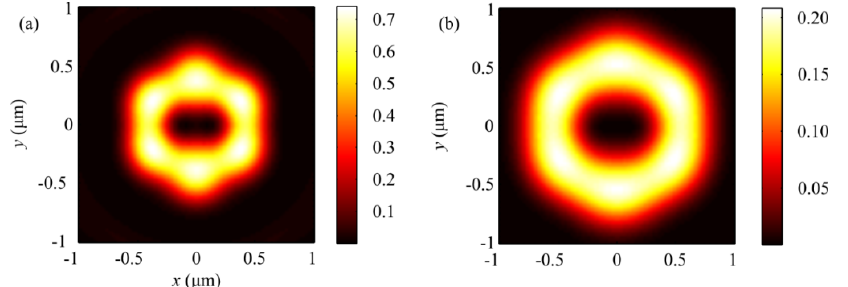
Figure 10. Changes in the focal spot intensity for the light field (Equation (1)) at m = 2, with decreasing numerical aperture of the lens to ( a ) NA = 0.8 and ( b ) NA = 0.6. The focal spot generated with a lens with NA = 0.95 is shown in Figure 3a.